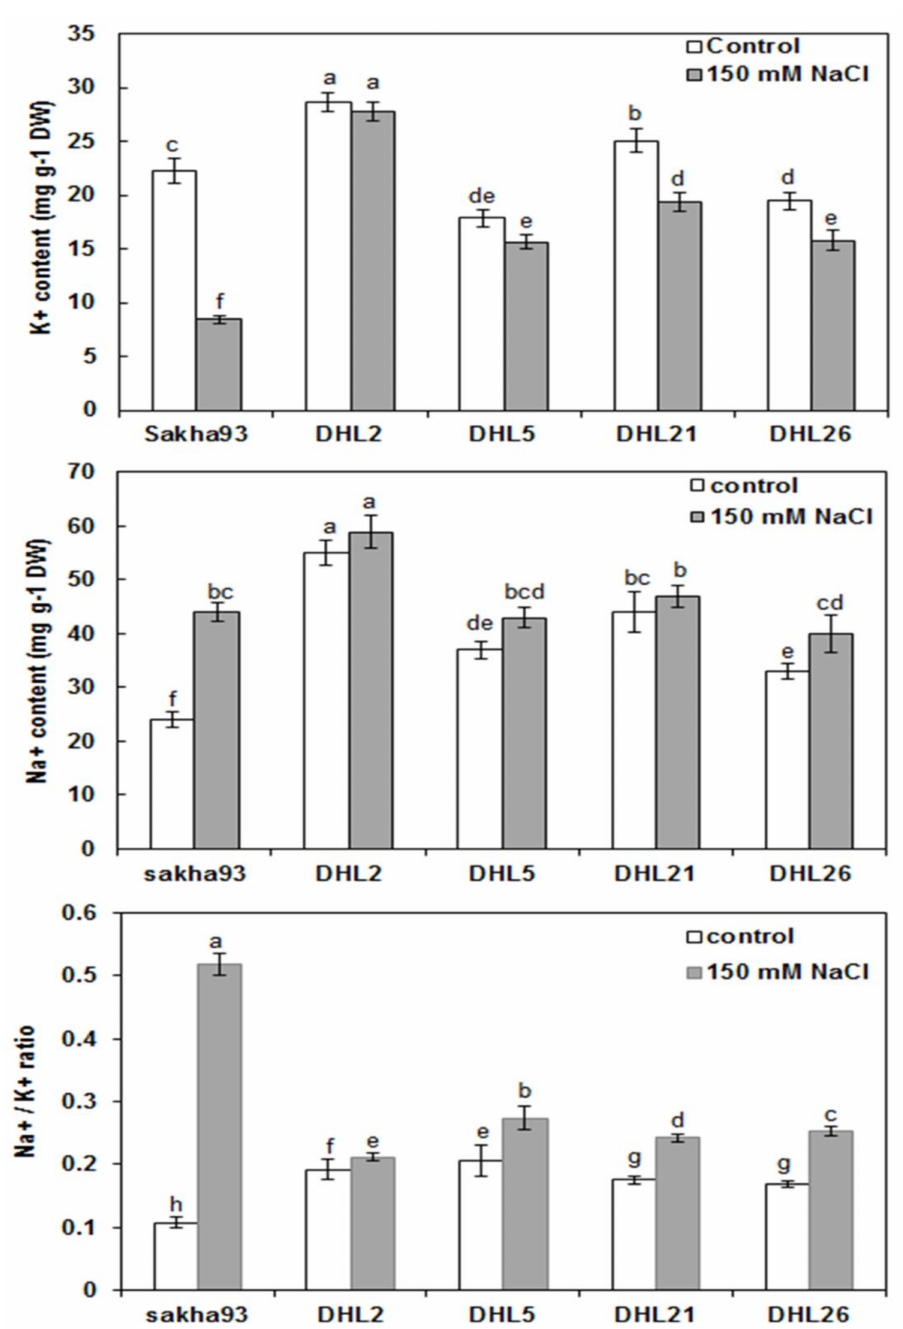
Figure 7. Estimation of Na + and K + accumulation in leaves of five wheat genotypes under normal and salt stress conditions. Values are presented as the mean ± SE of at least three replications, and values sharing the same letter for each treatment × genotype combination are not significantly different ( p ≤ 0.05) according to Duncan’s multiple range